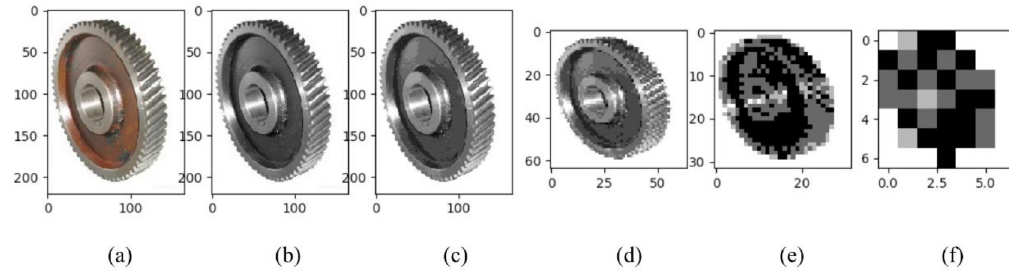
Fig 2. The original image of a gear, its grayscale image, and its feature map of sizes 220 × 165, 64 × 64, 32 × 32, and 7 × 7.